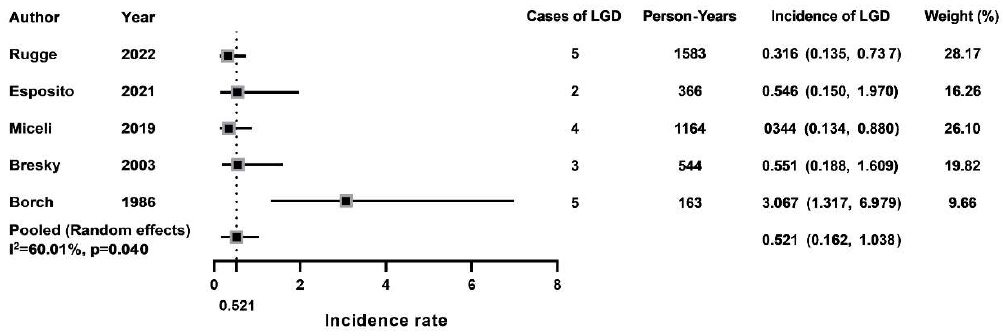
Figure 3. Gastric LGD incidence rates in AMAG patients [9–11,14,16].